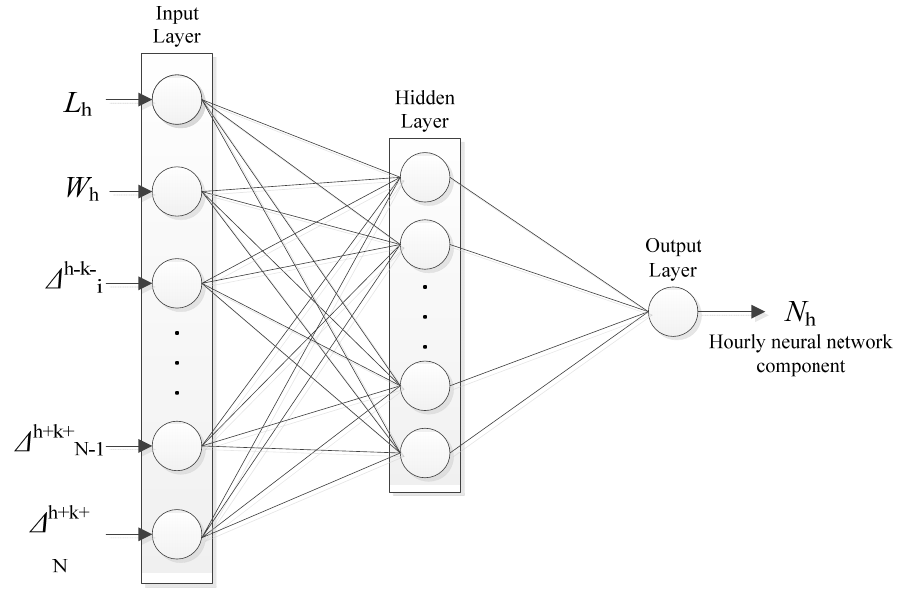
Figure 5. Proposed ANN model for hourly neural network component forecasting.